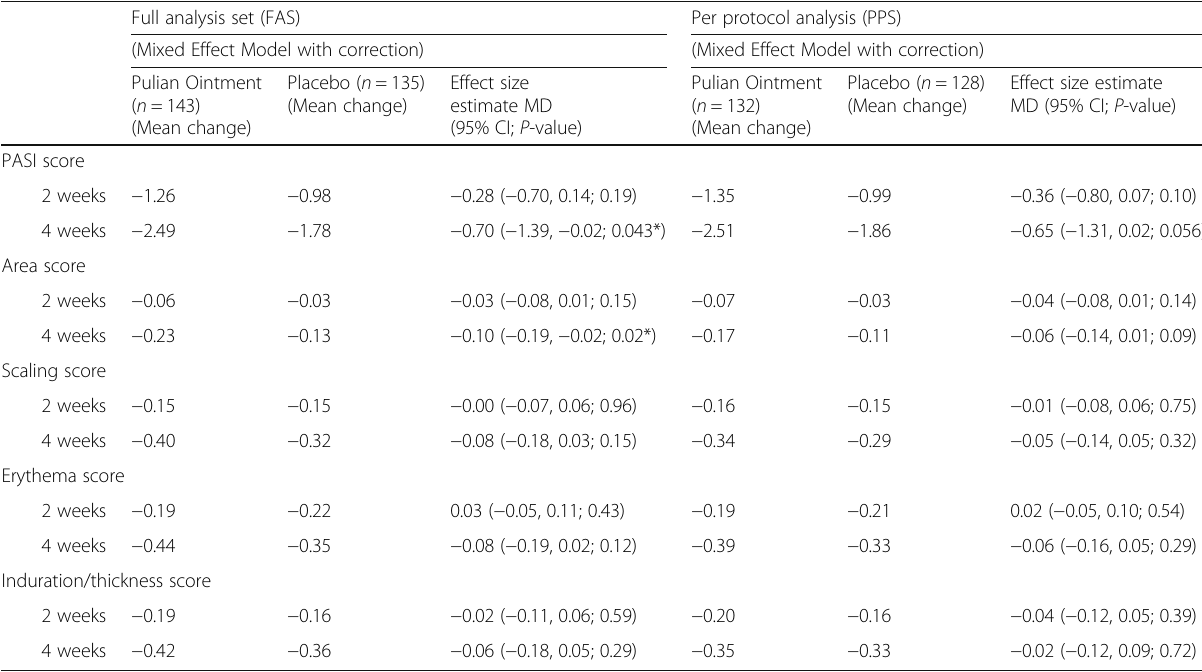
Table 2 Changes from baseline in PASI score and severity of each symptom and area of skin lesion in patients with psoriasis of blood-heat syndrome receiving Pulian ointment or placebo Full analysis set (FAS) Per protocol analysis